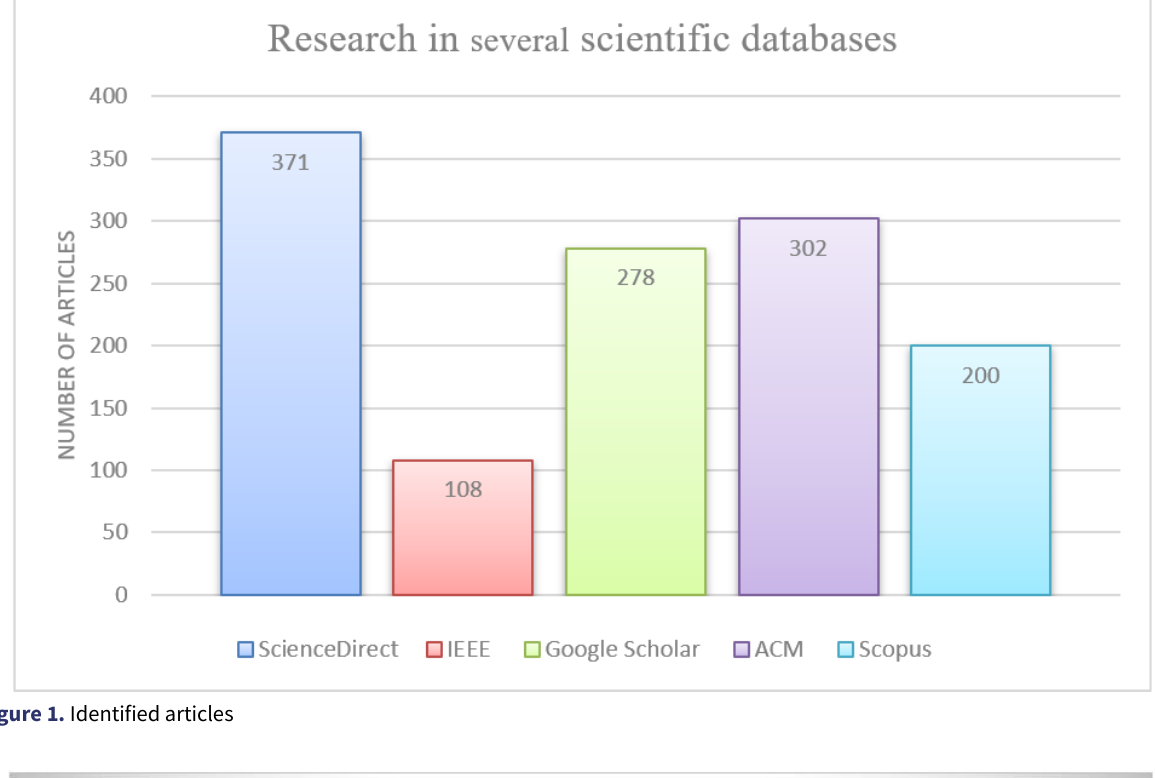
Figure 1. Identified articles